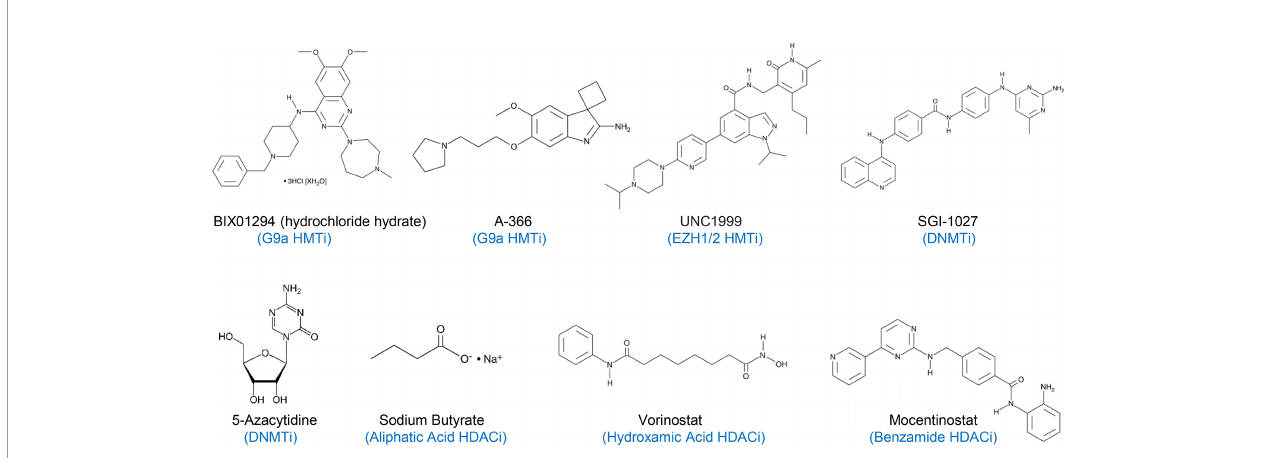
FIGURE 1 | A list of histone methyltransferase inhibitors (HMTi), DNA methyltransferase inhibitors (DNMTi), and histone deacetylase inhibitors (HDACi) used in this study. BIX01294 and A-366 are G9a-speci fi c HMTi, while UNC1999 is a speci fi c EZH1/2